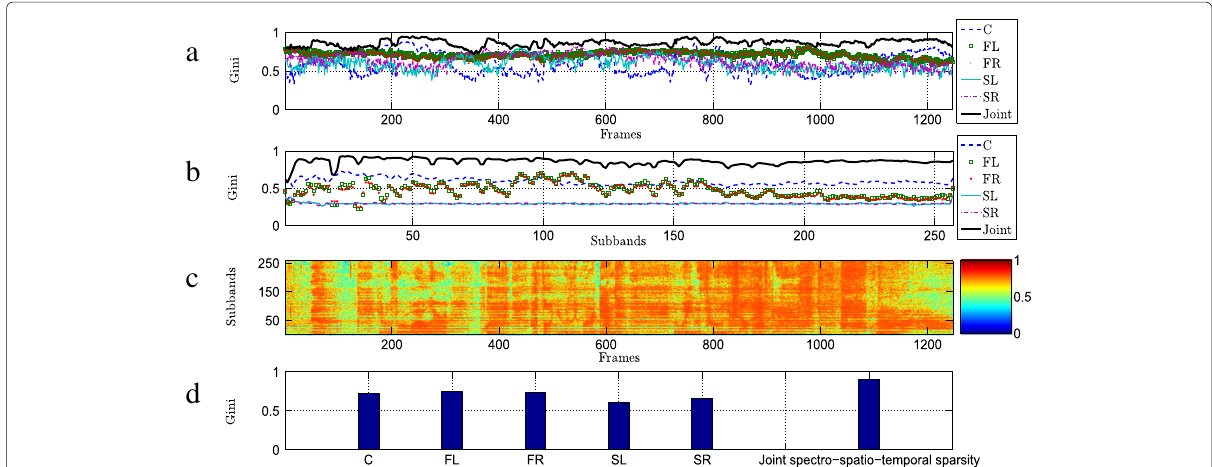
Fig. 5 Gini indices for a 10-s segment from the soundtrack of a five-channel movie signal; ( a ) spectral sparsity in each channel and joint spectro-spatial sparsity, ( b ) temporal sparsity in each channel and joint spatio-temporal sparsity, ( c ) spatial sparsity in each subband and frame, ( d ) joint spectro-temporal sparsity in each channel and joint spectro-spatio-temporal